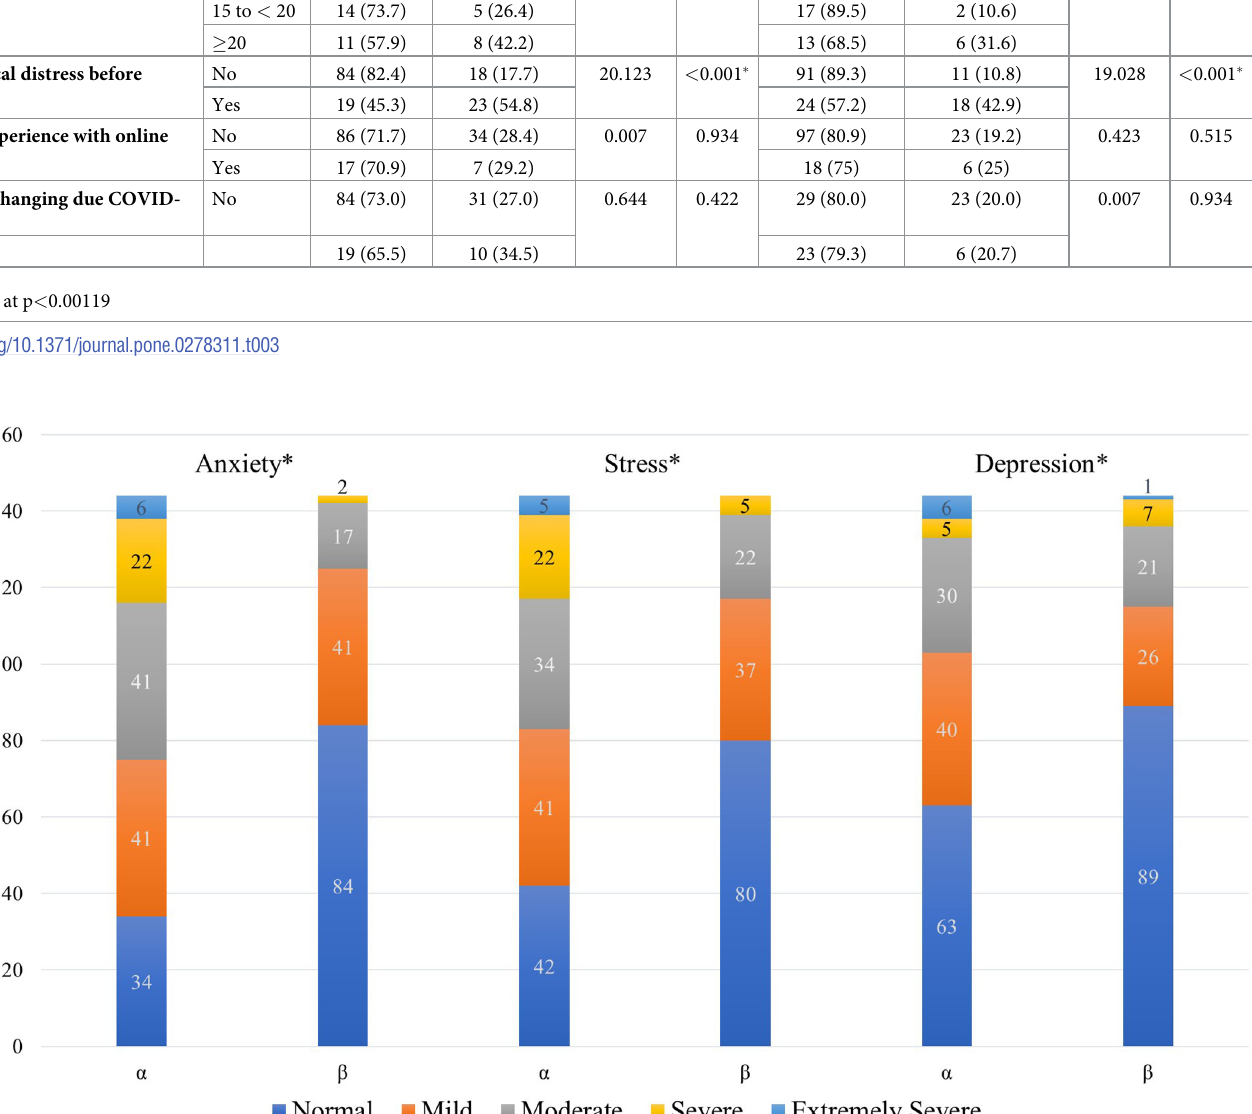
PLOS ONE | https://doi.org/10.1371/journal.pone.0278311 December1,